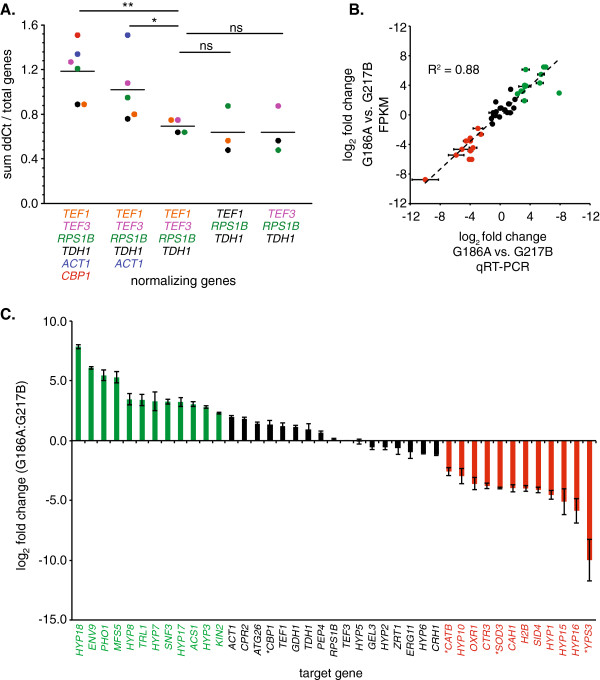
Validation of FPKM-based gene expression by quantitative RT-PCR. (A) Identification of genes with minimal variation in expression between strains. Gene expression of candidate normalization genes (TEF1, TEF3, RPS1B, TDH1, ACT1, and CBP1) was determined by qRT-PCR. Expression values were normalized to one member of the gene set and the total difference in cycle threshold between strains (y-axis) determined for the remaining genes. Colors correspond to which gene was used for normalization and the resultant total variation in cycle thresholds. The process was repeated iteratively by removing the gene, which when used as the normalizer, resulted in the greatest overall difference in expression between strains. Included genes are listed under the x-axis. Horizontal bars represent averages. Significantly different total cycle threshold variations determined by Student’s t-test are indicated (*, P < 0.5; **, P < 0.1; ns, non-significant). (B) Correlation between FPKM and qRT-PCR determination of gene expression between G186A and G217B yeasts. Data points represent the log2-transformed value of the fold-change in expression determined by qRT-PCR after normalization to TEF3 (x-axis) or by FPKM ratio (y-axis). Data point color indicates genes with no difference in expression (black; < 5-fold), genes upregulated in G186A (green; > 5-fold), and genes upregulated in G217B (red, > 5-fold). Error bars represent the standard deviation of the relative expression of three replicate yeast cultures for each strain. (C) Relative expression of selected genes in G186A yeasts compared to G217B yeasts. Bars represent the average fold change (log2) and error bars represent the standard deviation (n = 3 for each strain). Analyzed genes (x-axis) and data are colored to indicate genes with no enriched expression in either strain (black), genes upregulated in G186A yeasts (green; > 5-fold), and genes upregulated in G217B yeasts (red; > 5-fold). Asterisks denote genes with established roles in Histoplasma yeast virulence.